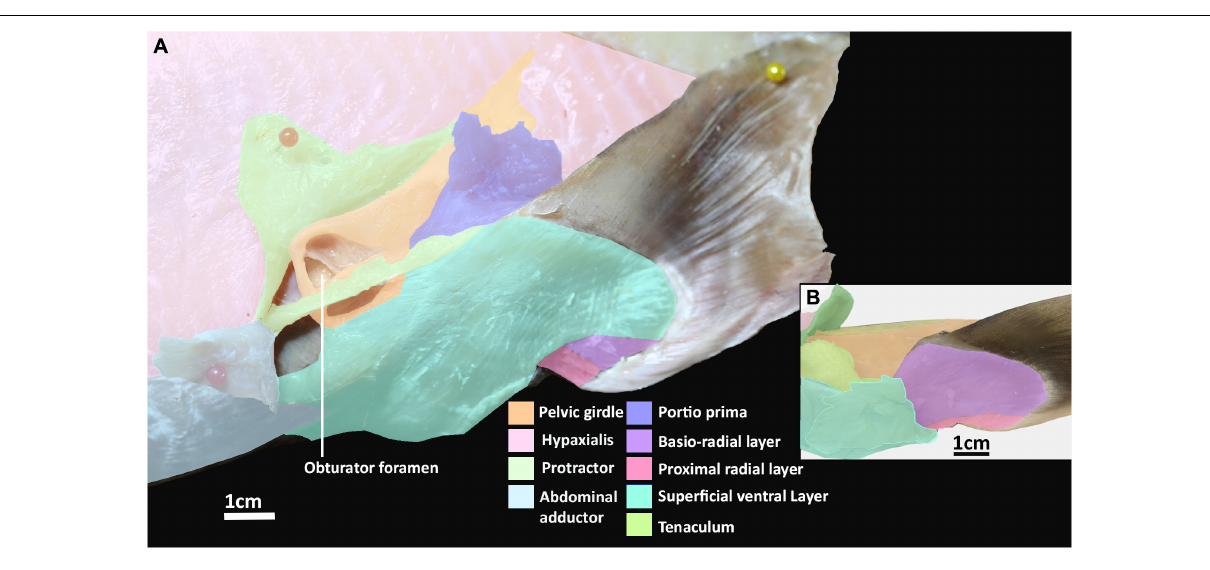
muscle are sexually dimorphic. In females this muscle inserts into distal surface of the second fin metapterygium ( Supplementary Figure 1 ; sensu Riley et al., 2017) and in males it inserts into the distal surface of the anterior clasper cartilage ( Figure 3A